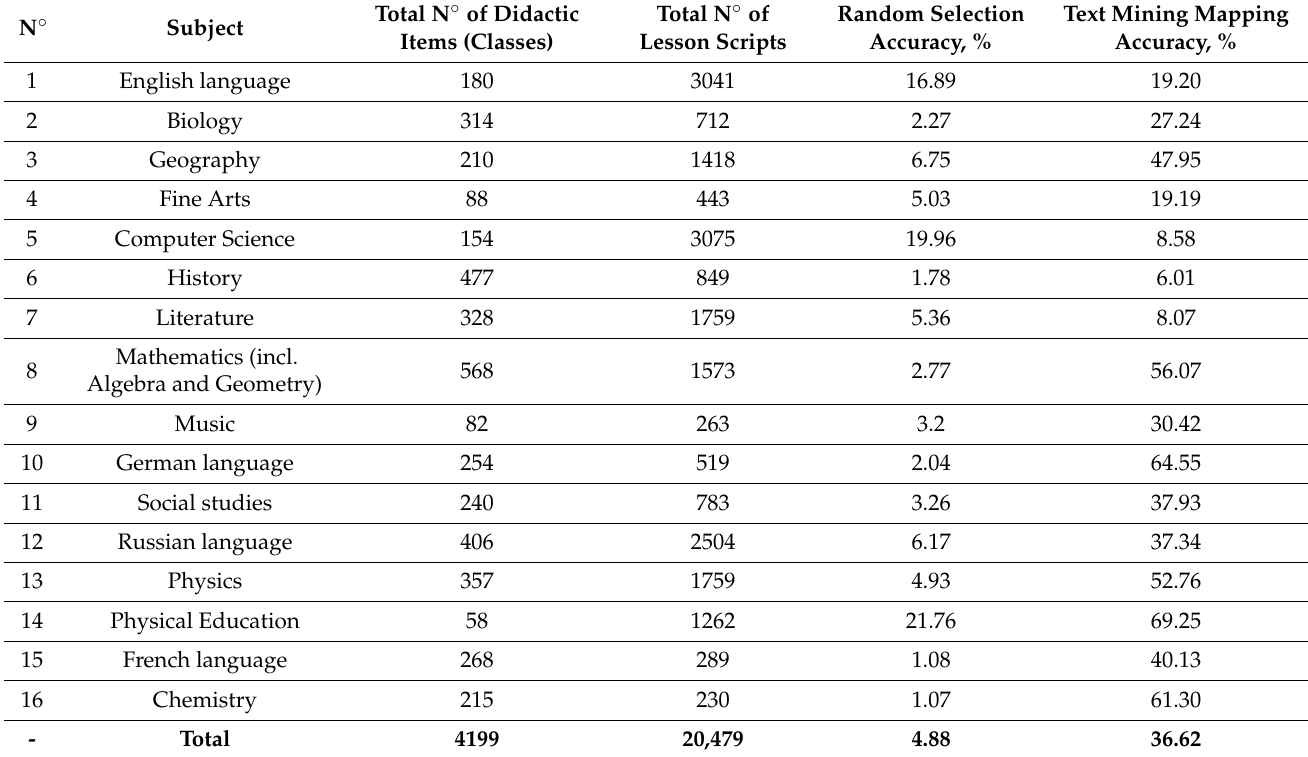
Table 5. The comparison of the proposed text mining method with random